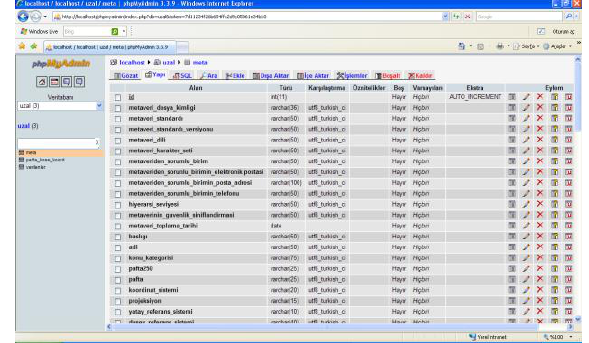
Figure 1. Database belonging to metadata components